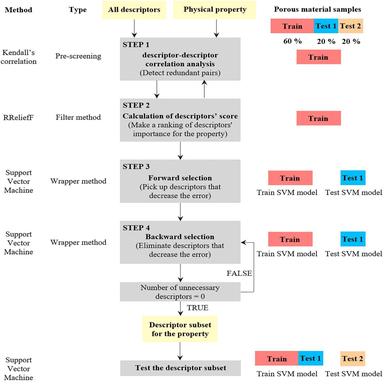
Proposed method for identifying an optimal descriptor subset to predict a target property.